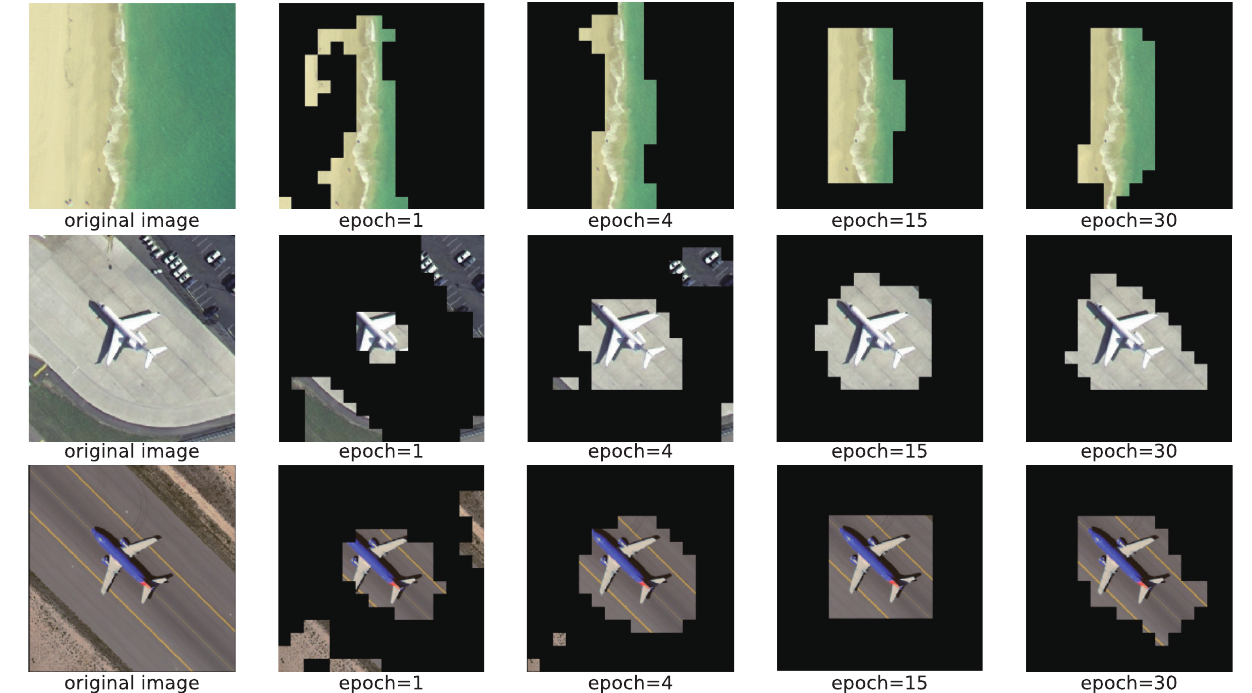
Figure 14. Example of 75% background masking on the UCM dataset.